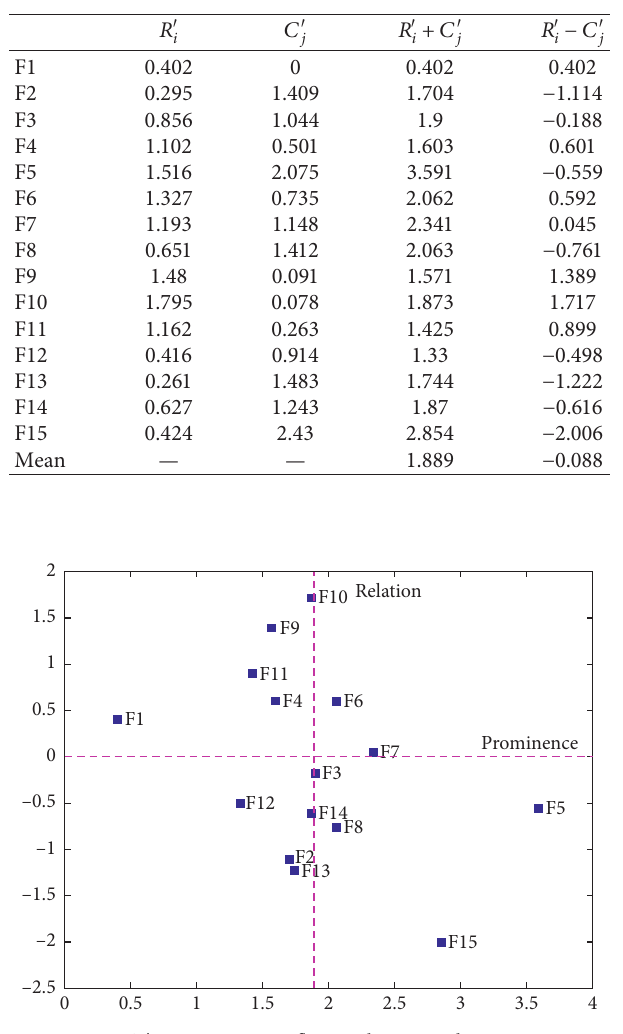
Table 5: The sums of given and received impact among influencing